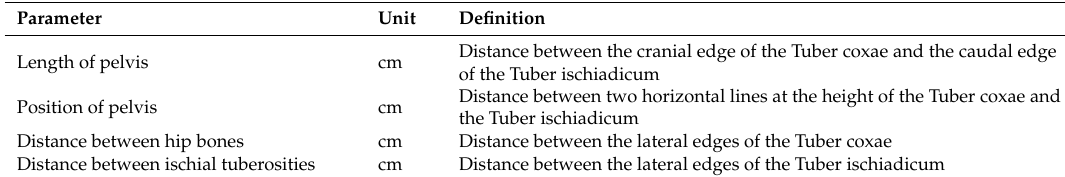
Table 1. Definitions of pelvic parameters derived from the